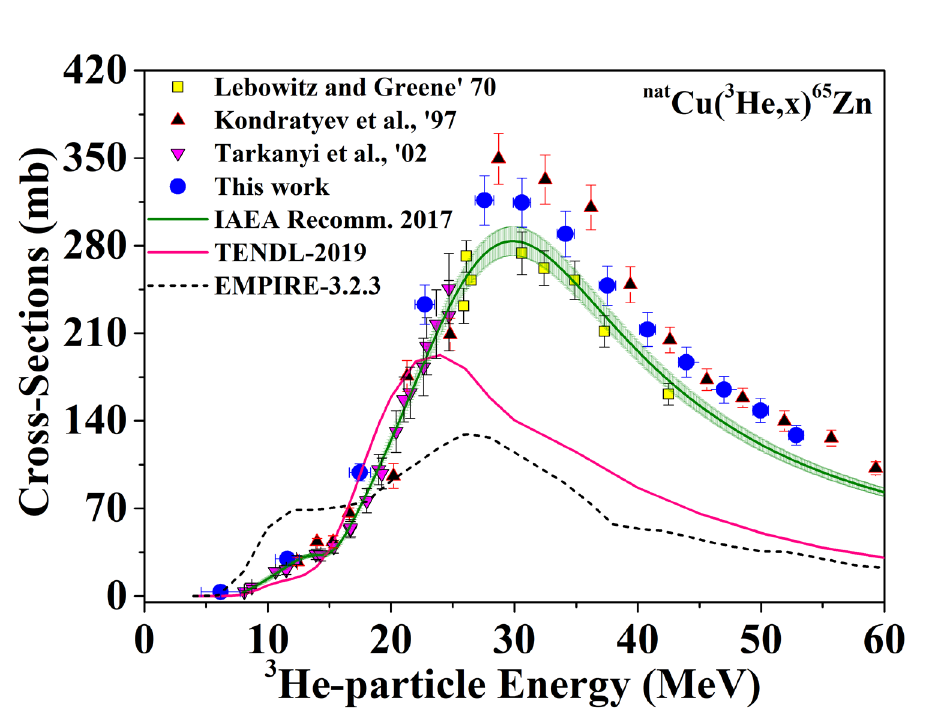
Table 1. Measured cross-sections of nat Cu( 3 He,x) 65 Zn reaction.